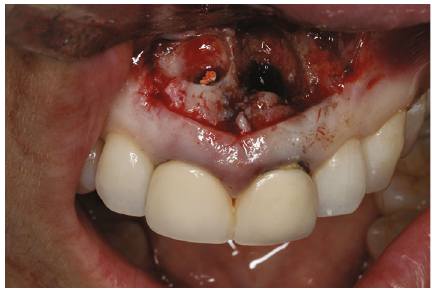
Figure 6: Raising of the full-thickness mucoperiosteal fl ap.